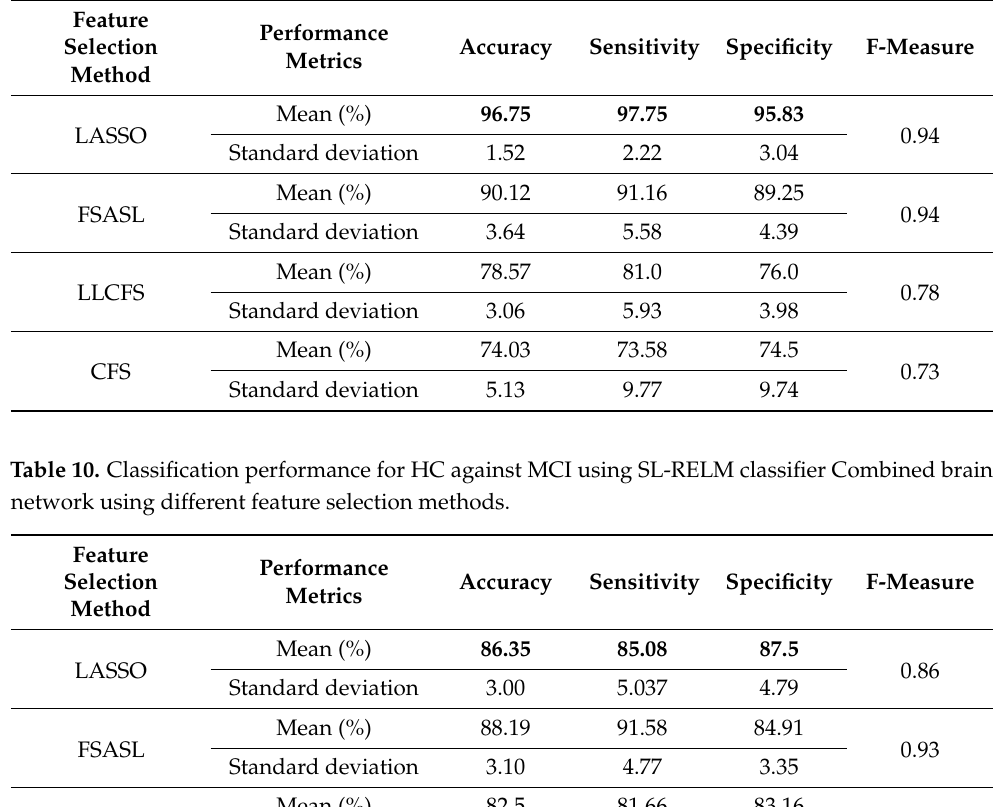
Table 9. Classification performance for MCI against AD using SL-RELM classifier on Combined brain network using different feature selection methods.